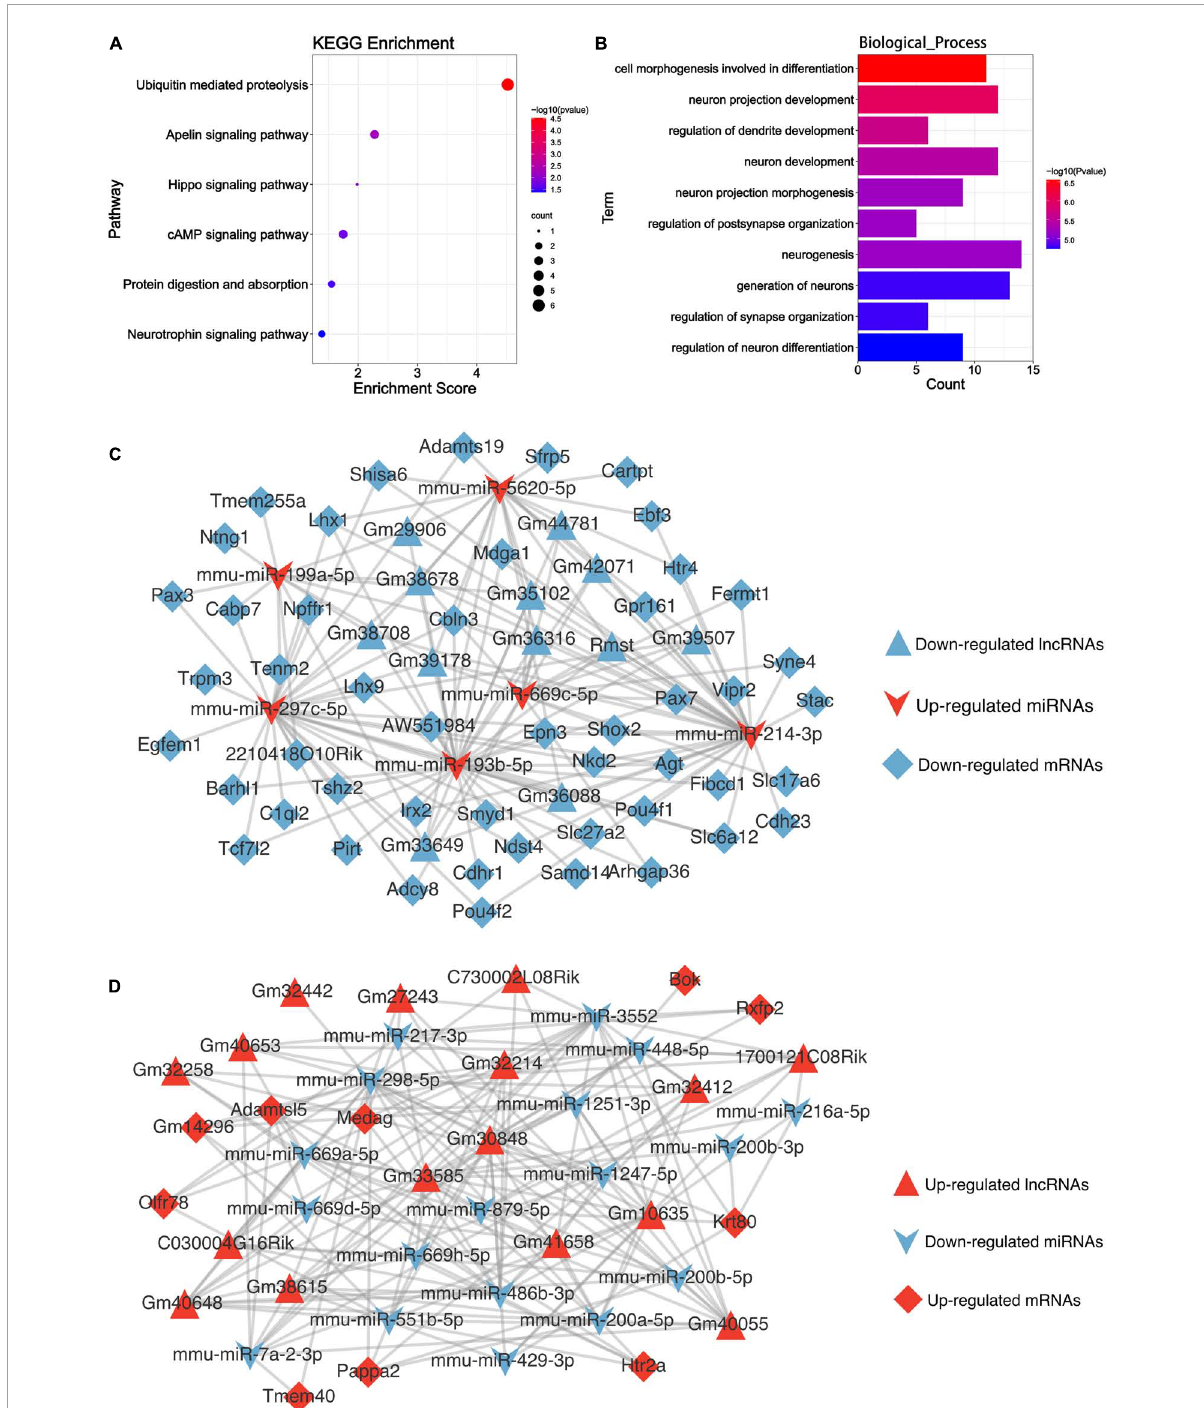
FIGURE7 Bioinformatics analysis results of the DEncRNAs. (A) The KEGG enrichment analysis of the parental genes of DEcircRNAs. The abscissa enrichment score represents the enriched extent of the pathway, and the ordinate represents each pathway. The size of the dots represents the number of genes in each pathway, the color of the dots represents the -log10 ( p -value), and the p -value was corrected by FDR. (B) The GO_BP enrichment analysis of the parental genes of DEcircRNAs. The abscissa represents the count in the GO_BP term, the ordinate represents the GO_BP term, and the column’s color represents the -log10 ( p -value). (C) The competing endogenous RNA network of the descending DElncRNAs. (D) The competing endogenous RNA network of the ascending DElncRNAs. Triangle, V shape, and diamond represent the lncRNA, miRNA, and mRNA, respectively. Red represents up-regulated, and blue is